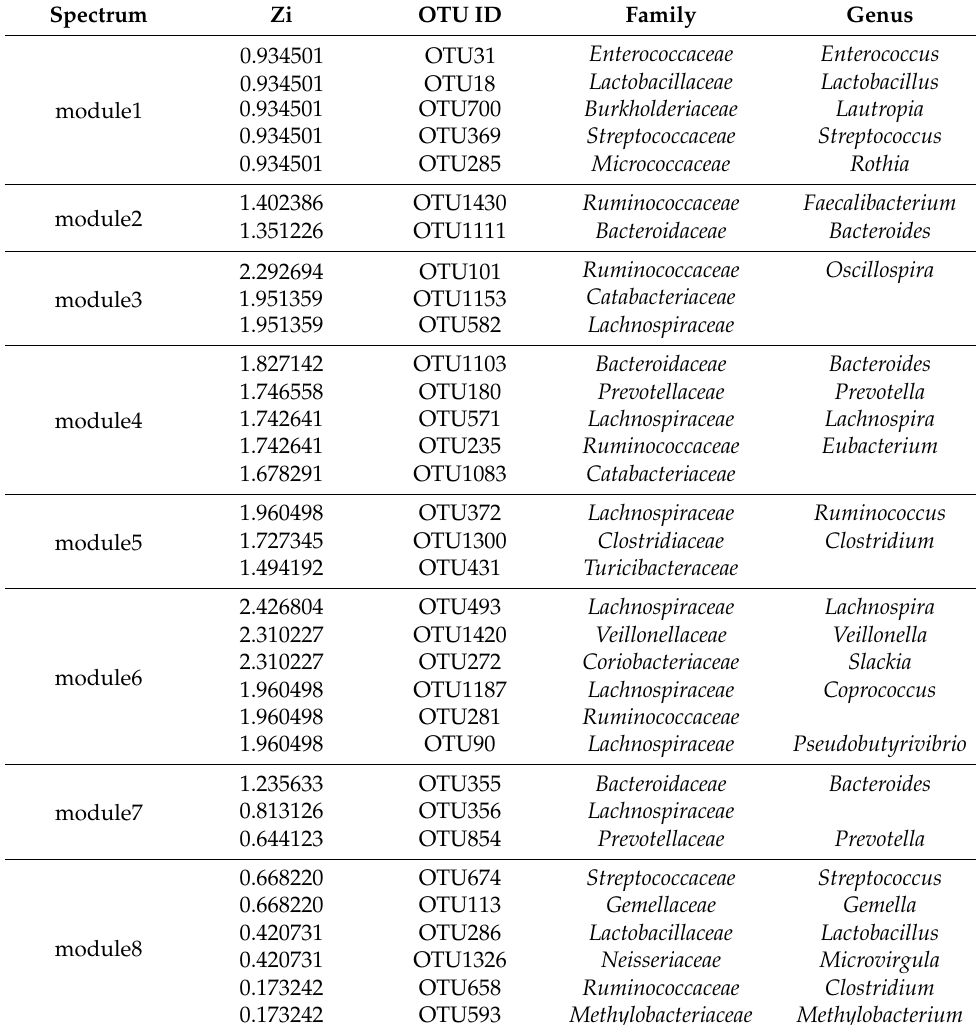
Table A7. Core flora and corresponding Zi values in each module of all samples group in network